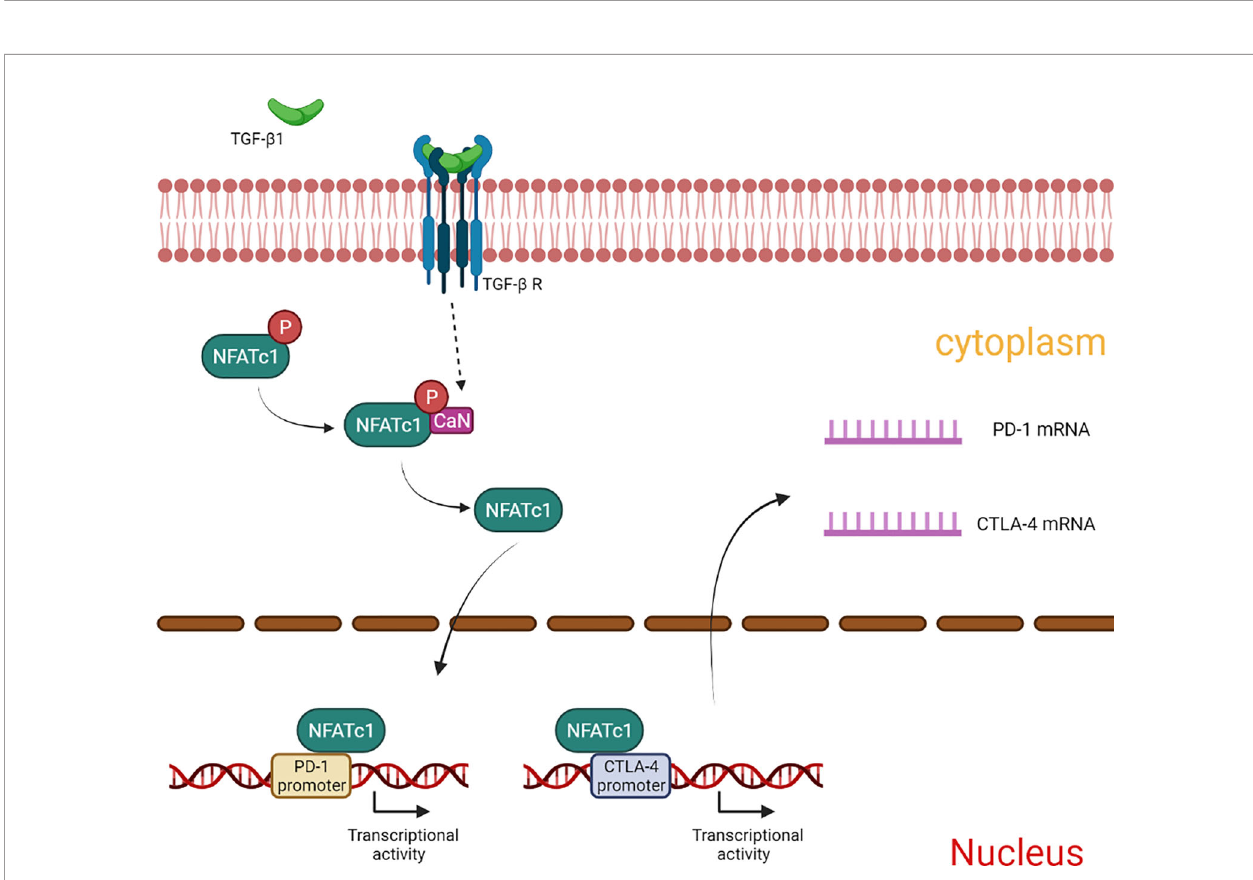
FIGURE 8 | Summary of the mechanism by which TGF- b 1 up-regulates the expression of PD-1 and CTLA-4 in T